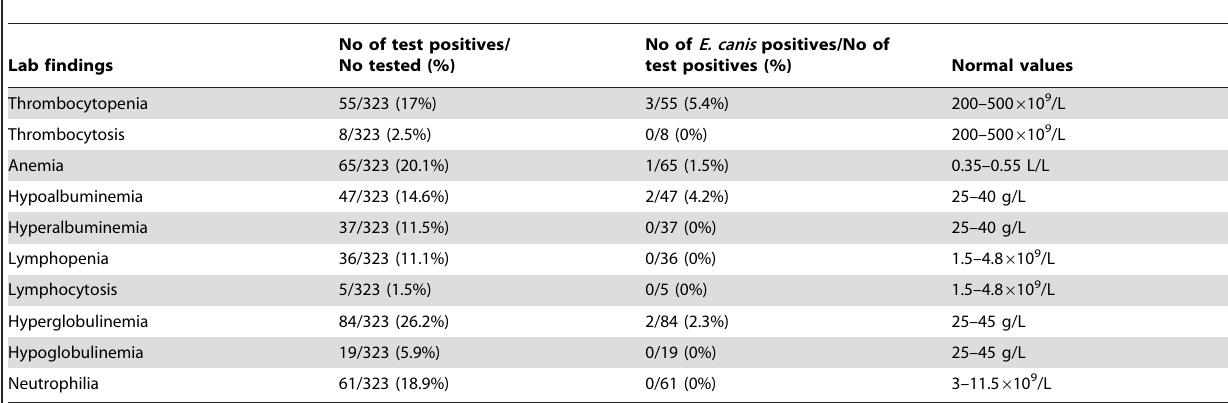
Table 2. Association between E.canis infection status and abnormal laboratory findings for clinic cases.